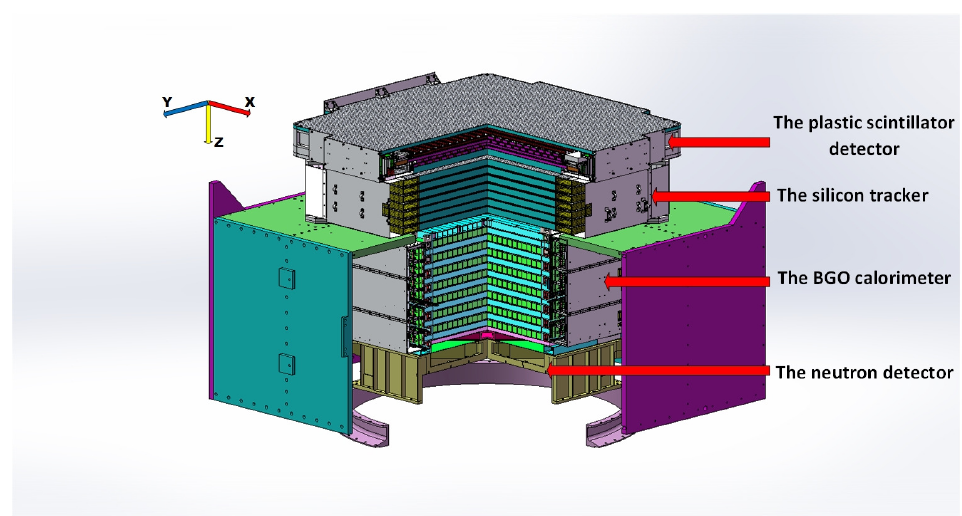
Figure 1. The DAMPE detector